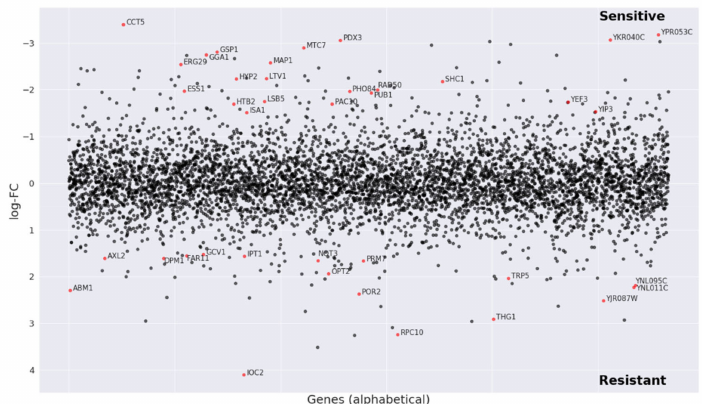
Figure 5. Chemogenomic screen. The pool of tagged 5936 deletion mutants was grown for 20 generations in thepresenceof3 (cid:48) prenyluliginosinB(150 µ g)and1%DMSO(control). Log2ratio(controlintensity / treatment intensity) was calculated and plotted as a function of gene. The genome-wide readout of